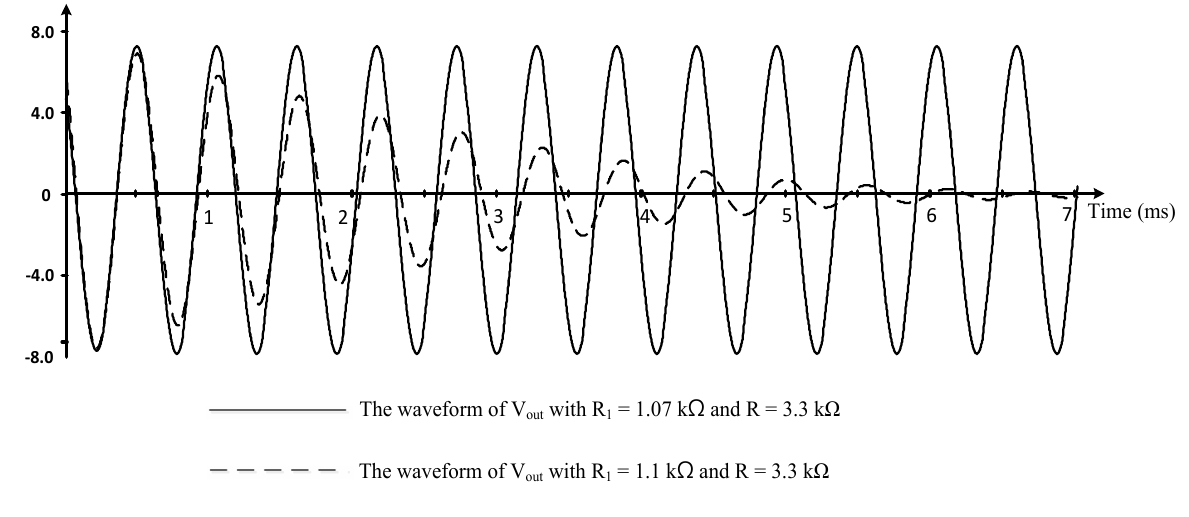
Figure 10. The output waveforms for the oscillator in Figure 6 with different oscillation